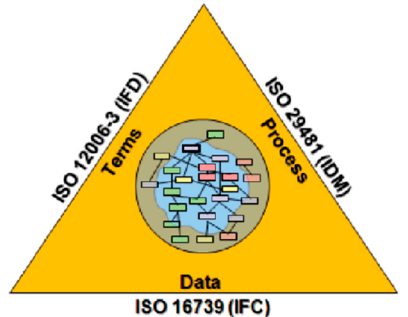
Figure 3. Open BIM standards (Courtesy of buildingSMART [36]).